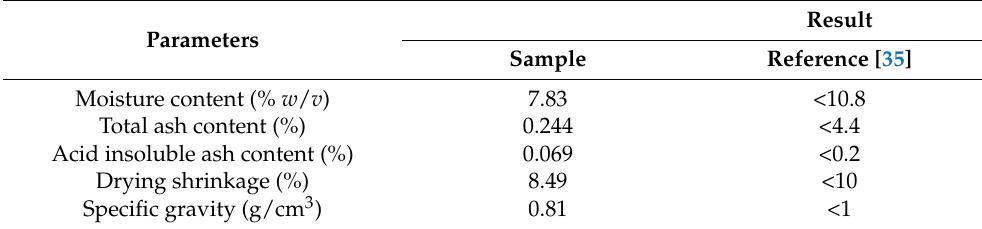
Table 3. Standard parameters of mangosteen peel extract. Parameters